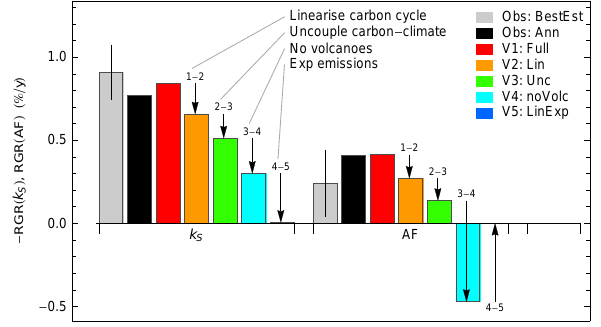
Figure 3. Relative growth rates of k S and AF over 1959.0–2013.0, at five accumulating levels of model simplification: (V1, red) full model, (V2, orange) linearised, (V3, green) uncoupled, (V4, light blue) no volcanoes, and (V5, dark blue) LinExp idealisation. The labelled vertical arrows indicate the model simplification occurring at each step (e.g. linearisation of the carbon cycle in the step from V1 to V2). Corresponding trajectories of CO 2 and temperature are shown in Fig. 6, and trajectories of k S and AF in Fig. 7. Note that RGR (k S ) is negative and is plotted with reversed sign. Black bars show observed trends estimated from annual data using Eq. (A1) in Appendix A; these observed trend estimates are directly comparable with model estimates, which were obtained in the same way. Grey bars with ± 1 σ confidence intervals are the best trend estimates from Tables 1 and 2, obtained with Eq. (A2). There are small differences between the estimates (within ± 1 σ confidence intervals). Reasons for the use of these two different estimation methods are given in the text and in Appendix